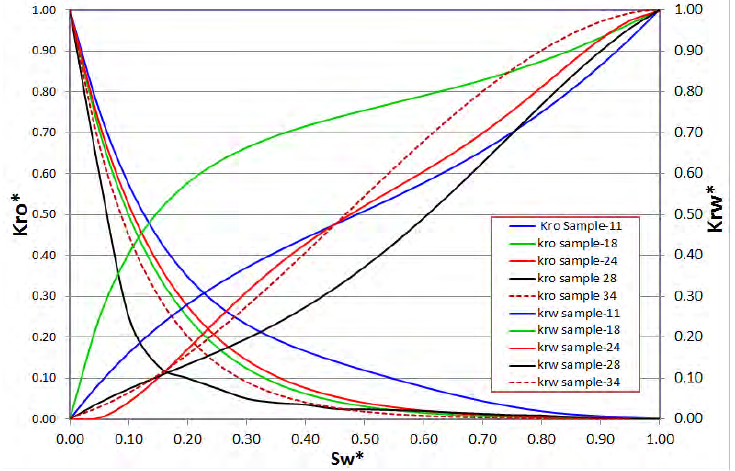
Figure 10. Normalized relative permeability for Upper